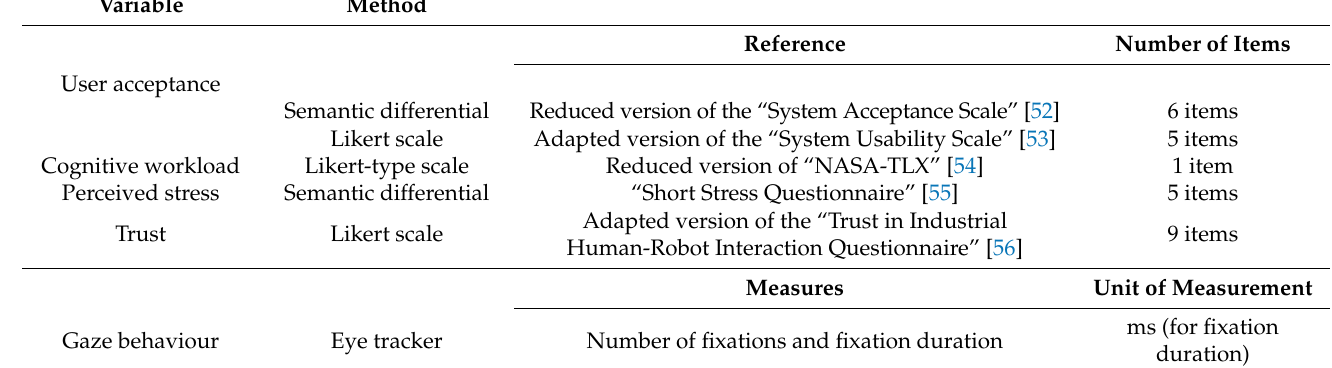
Table 2. List of variables and